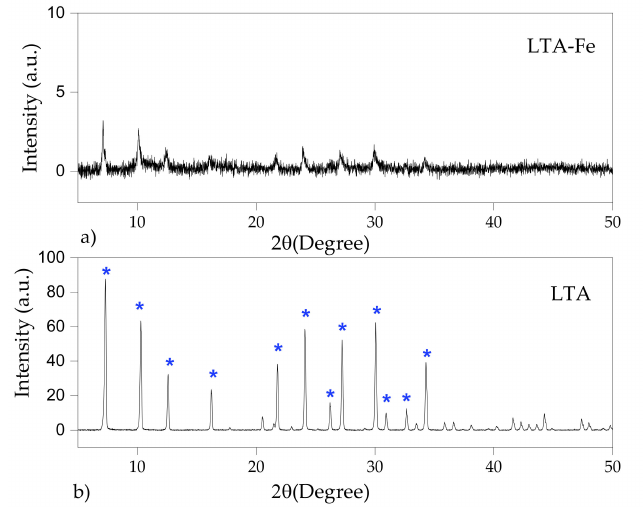
Figure 3. XRD of the LTA zeolite: ( a ) parent form LTA and ( b ) iron form LTA-Fe.